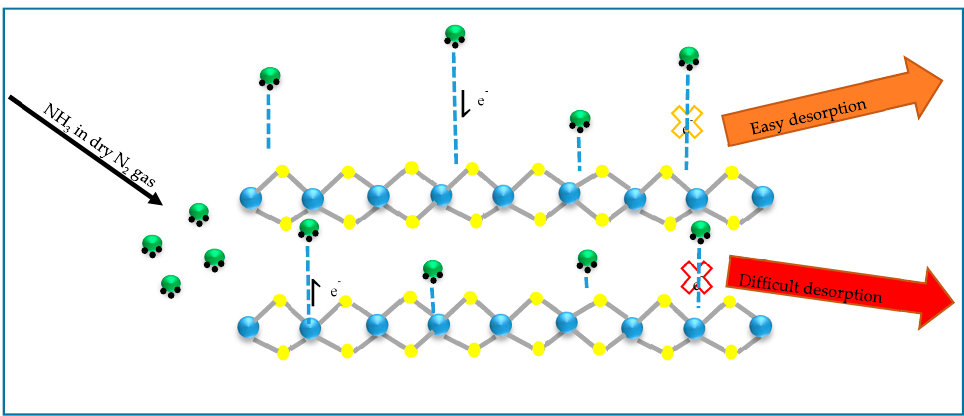
Figure 12. Schematic illustration of the interfacial interaction of NH 3 molecules with the surface and interlayer of WS 2 . The illustration is adapted from Qin, et al. [11].